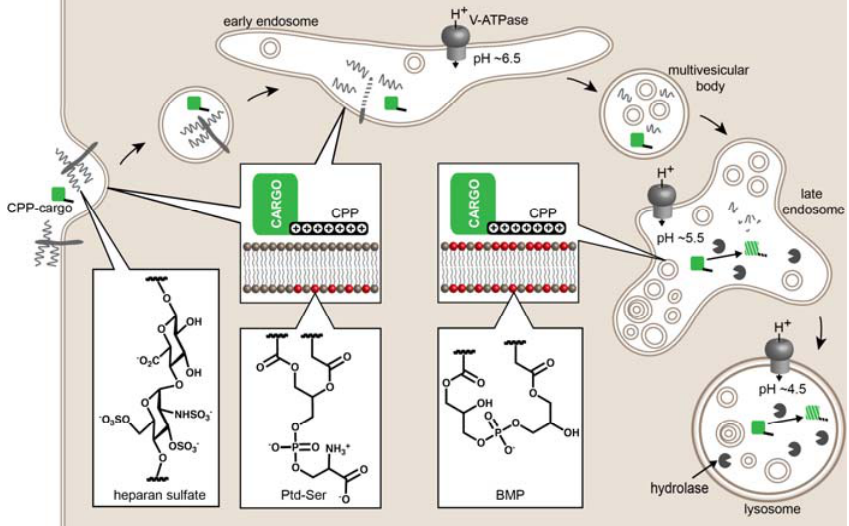
Figure 1. Model of the trafficking of a CPP-cargo conjugate through the endocytic pathway. From left to right: A CPP-cargo binds to HSPGs on the cell surface and induces endocytosis. Endocytosis leads to uptake and entrapment of the CPP-cargo inside an endocytic vesicle. The endosomal membrane contains the lipid phosphatidylserine (Ptd- Ser) in its outer leaflet. During endosomal maturation, a vacuolar H + -ATPase acidifies the lumen of endocytic organelles. The CPP-cargo reaches early endosomes (pH~6.5). Concurrently, hydrolases partially degrade HSPGs and release HS fragments. Upon further maturation, the CPP-cargo reaches multivesicular bodies, late endosomes (pH~5.5), and lysosomes (pH~4.5). The membrane of the intraluminal vesicles of late endosomes is enriched with BMP. HS is further degraded to smaller fragments. The CPP-cargo is susceptible to degradation due to the low pH and lysosomal